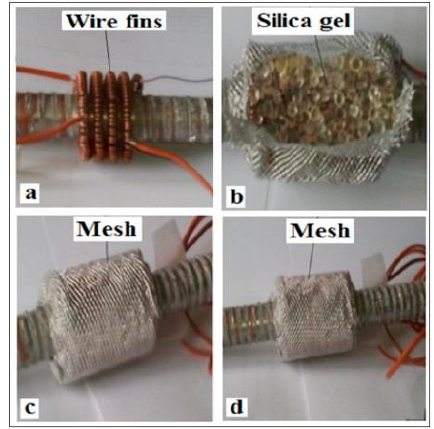
Figure 12. Setting up the wire woven heat transfer experiment.